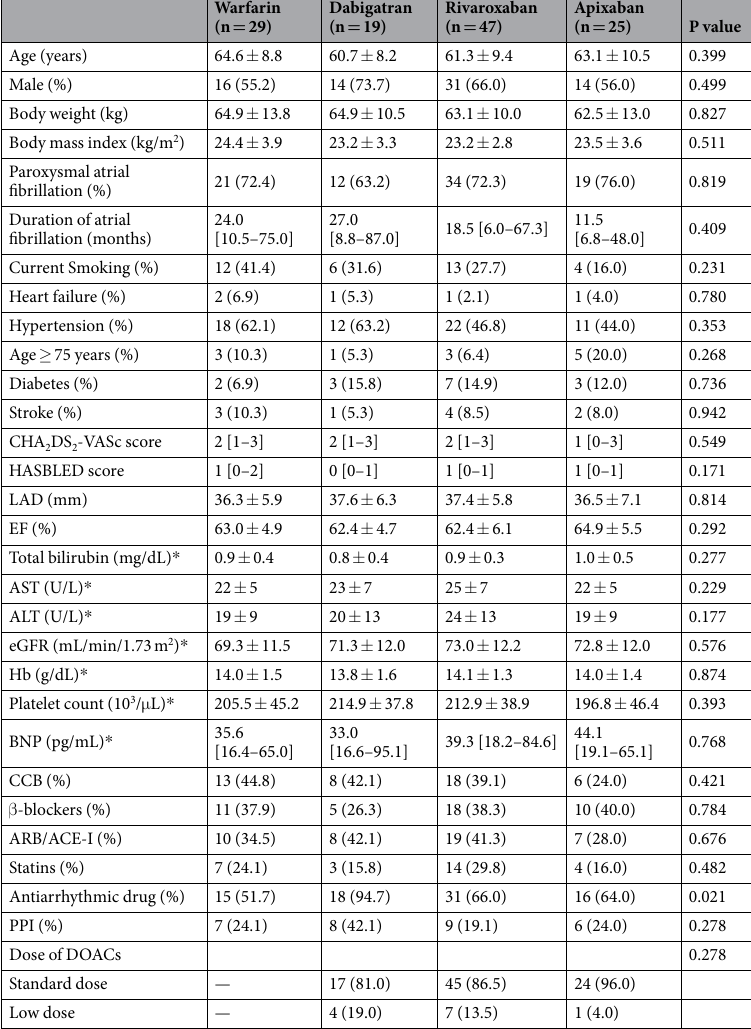
Table 1. Comparison of baseline characteristics of patients treated with warfarin and the three types of DOACs. DOACs = Direct oral anticoagulants, CHA 2 DS 2 -VASc = congestive heart failure,